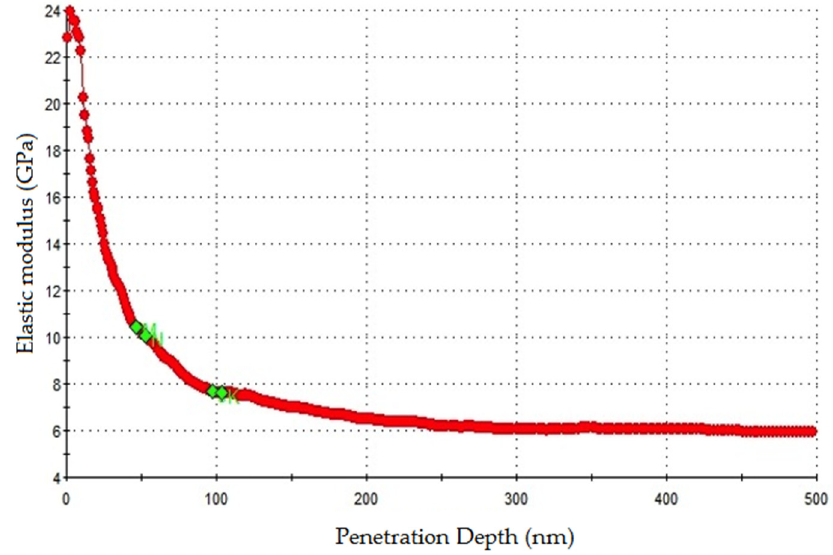
Figure 11. Variation of elastic modulus with the depth of indentation on vinyl ester matrix.